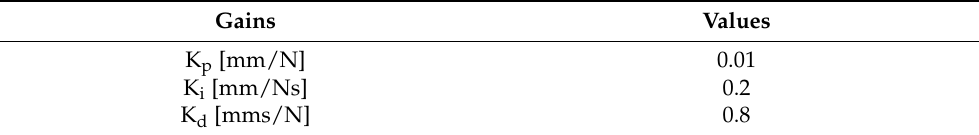
Table 3. The gains for the PID controller.